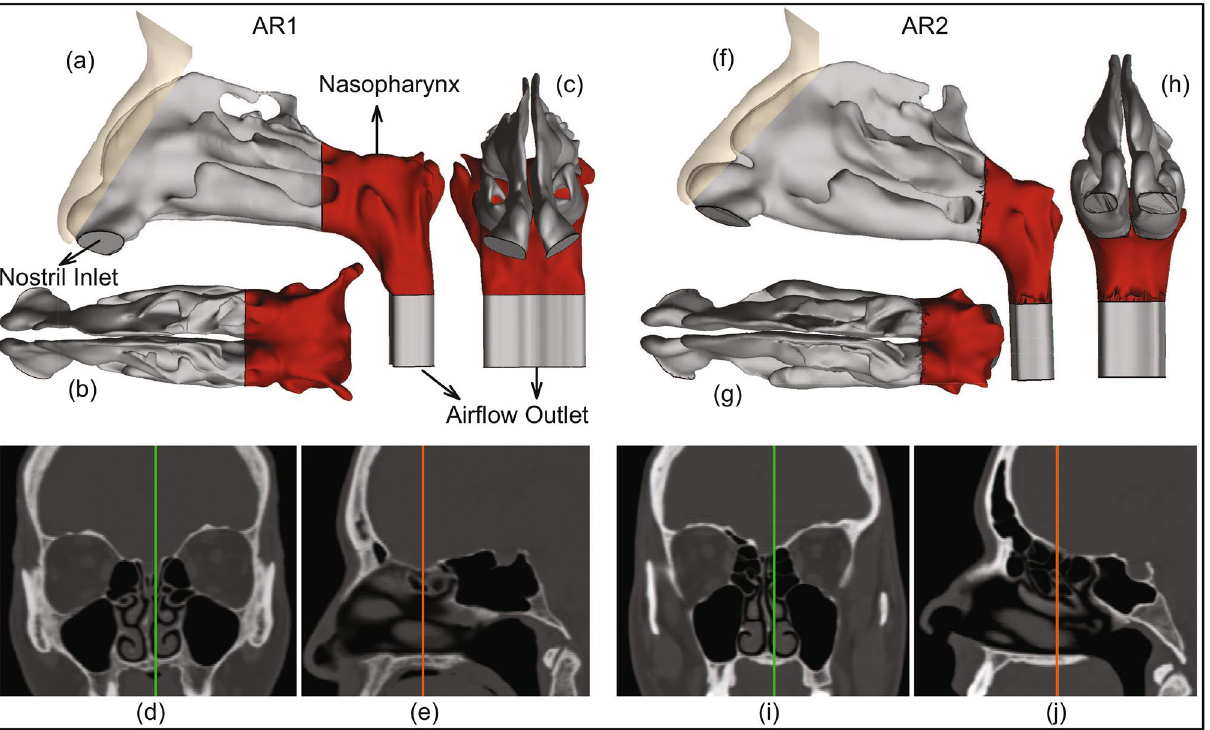
Figure 1. Anatomically realistic nasal airway geometries: ( a – c ) respectively depict the sagittal, axial, and coronal views of the computed tomography (CT) based nasal domain in anatomic reconstruction 1 (AR1). ( d , e ) Representative CT slices for AR1. Therein, the green line in ( d ) corresponds to the location of the sagittal section shown in ( e ); the orange line in ( e ) corresponds to the location of the coronal section shown in ( d ). ( f – h ) Respectively depict the sagittal, axial, and coronal views of the CT-based nasal domain in anatomic reconstruction 2 (AR2). ( i , j ) Representative CT slices for AR2. Therein, the green line in ( i ) corresponds to the location of the sagittal section shown in ( j ); the orange line in ( j ) corresponds to the location of the coronal section shown in ( i ). The digital reconstructions only consider the main nasal cavity and leave out the sinus appendages. Nasopharynx is marked in red on the top row graphics. Visuals in ( a – c ), ( f – h ) are generated using the software ICEM CFD 15.0 (ANSYS Inc., Canonsburg, Pennsylvania; link to softw are homep age). The scans on ( d , e ) and ( i , j ) are extracted from the image processing software Mimics Research 18.0 (Materialise, Plymouth, Michigan; link to softw are homep